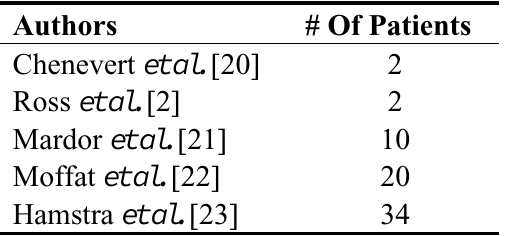
Table 2. Summary of related methods in GBM tumor treatment response using